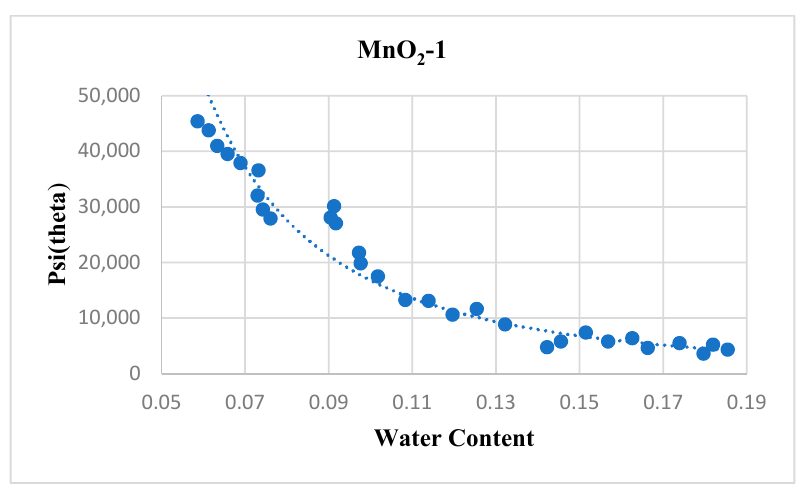
Figure 7. Decay model for MnO 2 -1 nanoparticles.